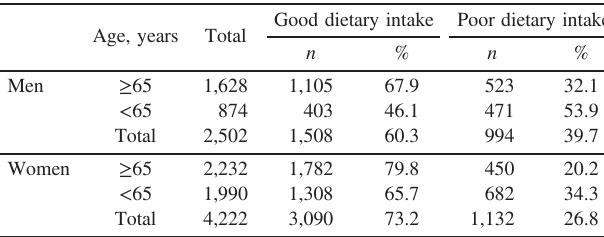
Table 3. Dietary intakes by age group and